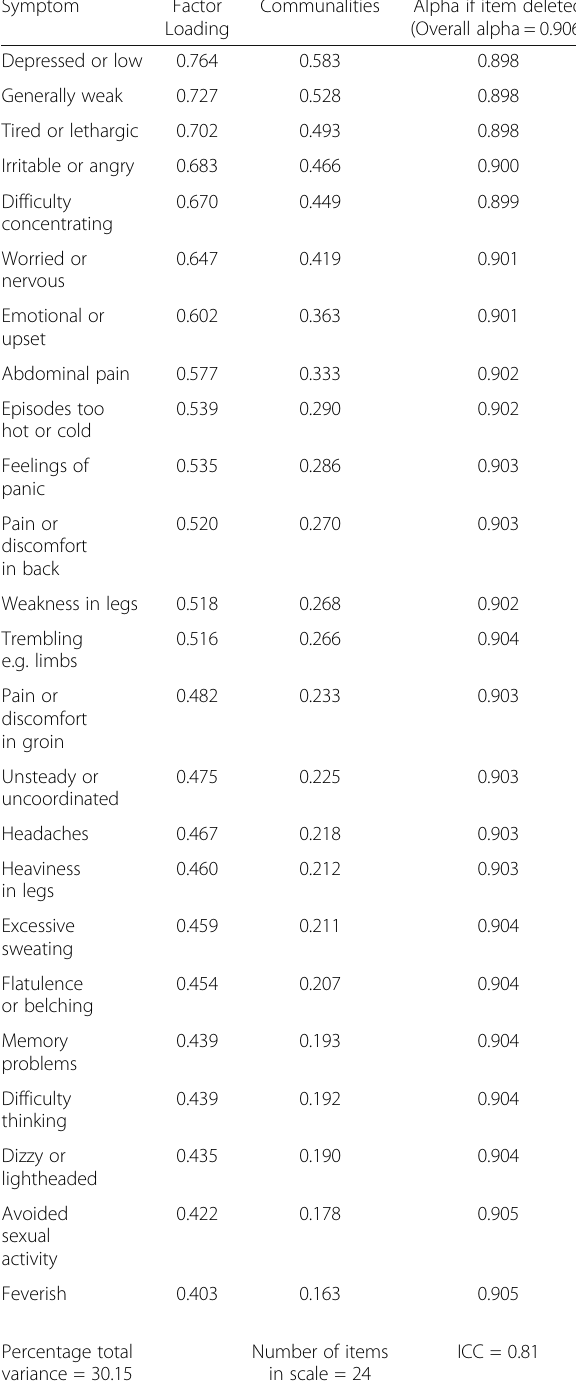
Table 7 AneurysmSRQ composite symptom score - factor loadings, communalities and reliability coefficients, ordered by